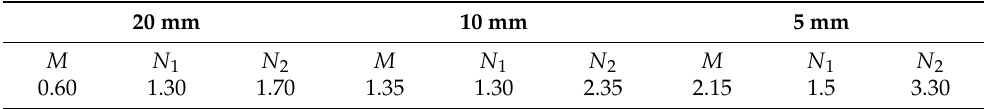
Figure 7. Mode and quantitative determination method of influenced zone. The values of M , N 1 , and N 2 corresponding to the 3-level tunnel displacement control standards of 20 mm, 10 mm, and 5 mm are listed in Table 3. Table 3. Determination parameters of influenced zones.